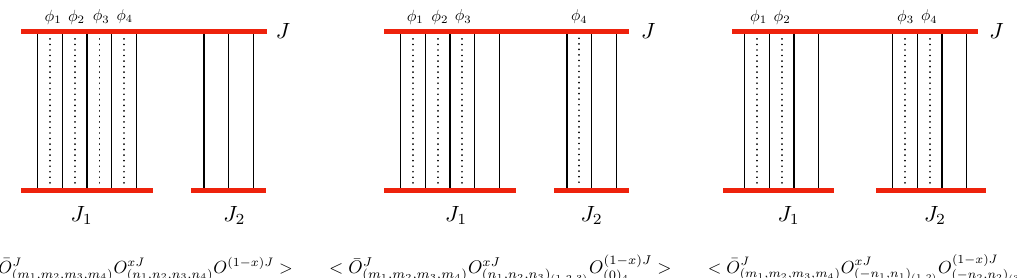
Figure 2 . The planar three-point